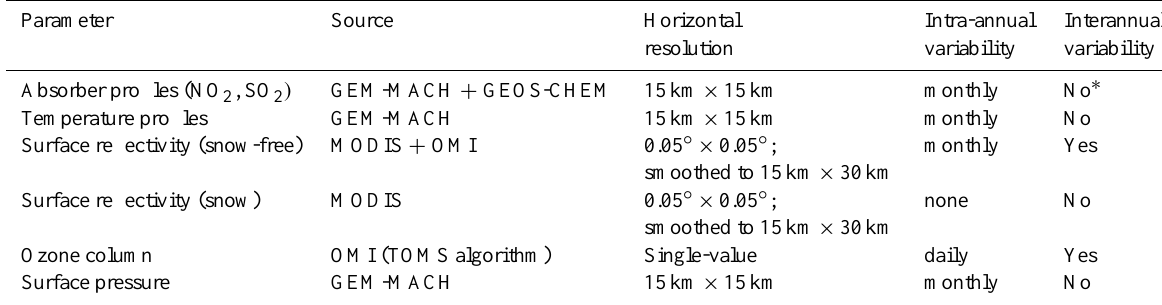
Table 1. Summary of air mass factor input